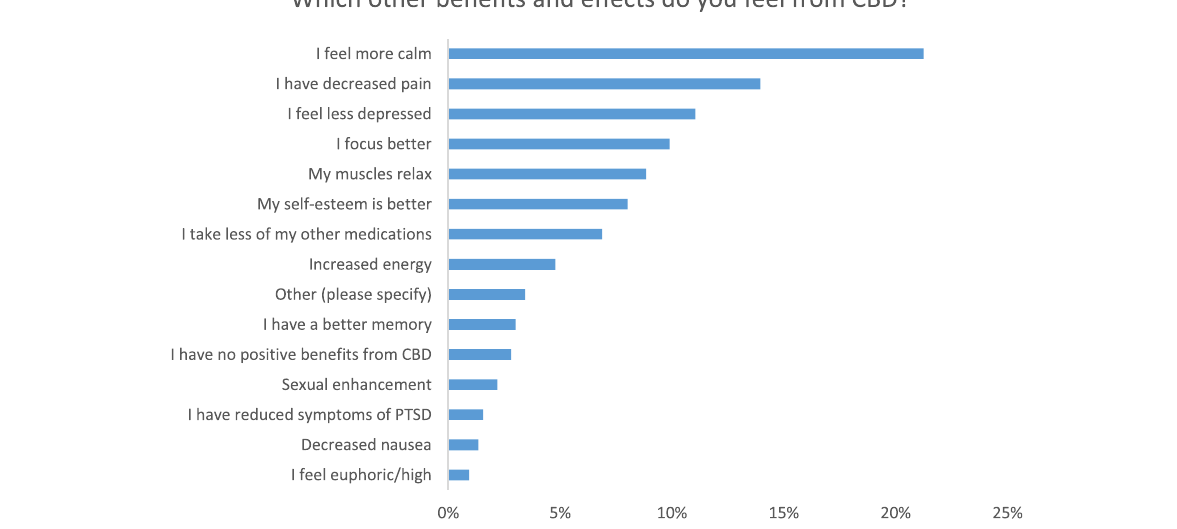
Fig. 3 Other perceived benefits of cannabidiol amongst adult cannabidiol users. Respondents were asked what other benefits or effects they feel from using cannabidiol. Participants were allowed to select multiple options. X -axis is the percentage of total responses ( n =